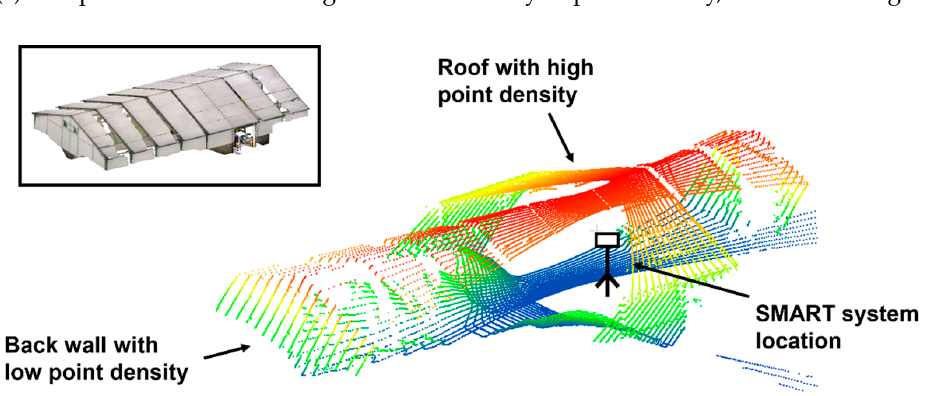
Figure 8. Example of varying orientation of planar features and significant variability in point density in one scan from the SMART system, colored by height. The TLS point cloud of the facility colored by RGB is shown in the upper left box.